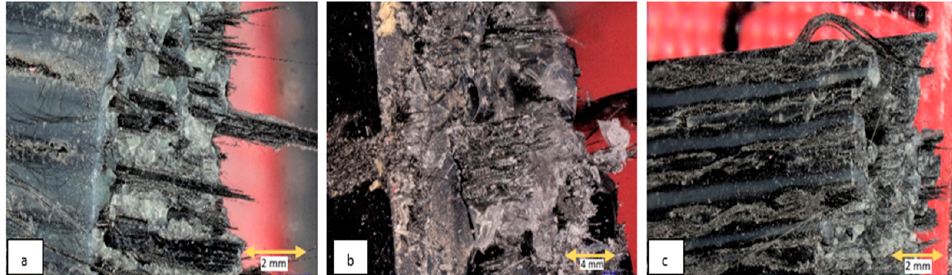
Figure 11. Failed flexural specimen.